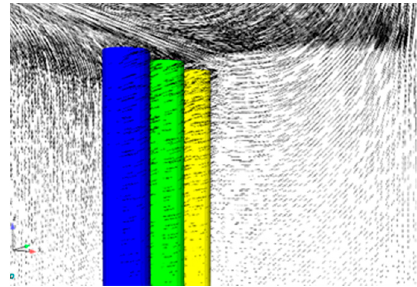
Figure 6. Variations of the flow velocity around the pile without cap. Challenges 2017 , 8 , 30